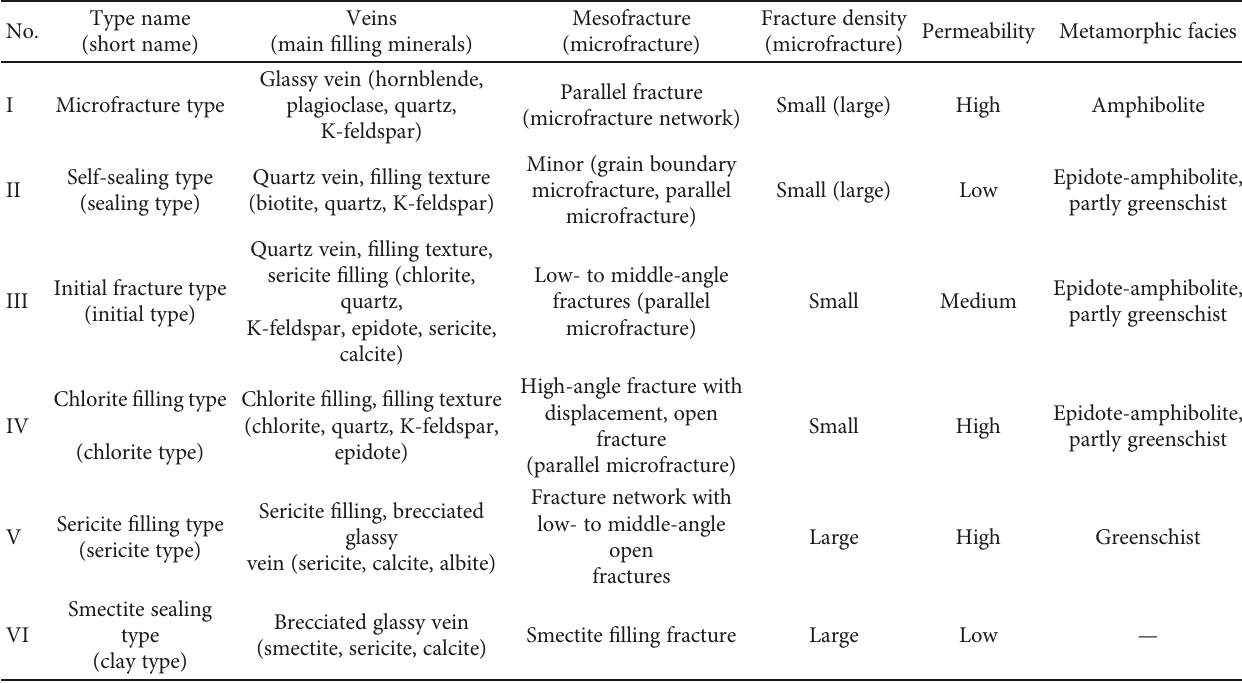
Table 1: Types of hydrothermal fl uid fracture of the Toki granite. The characteristics of the fracture are shown based on data from three boreholes obtained in this study. The clay type was related to crustal deformation and erosion. Permeability was divided into three categories based on the existing in situ permeability test data